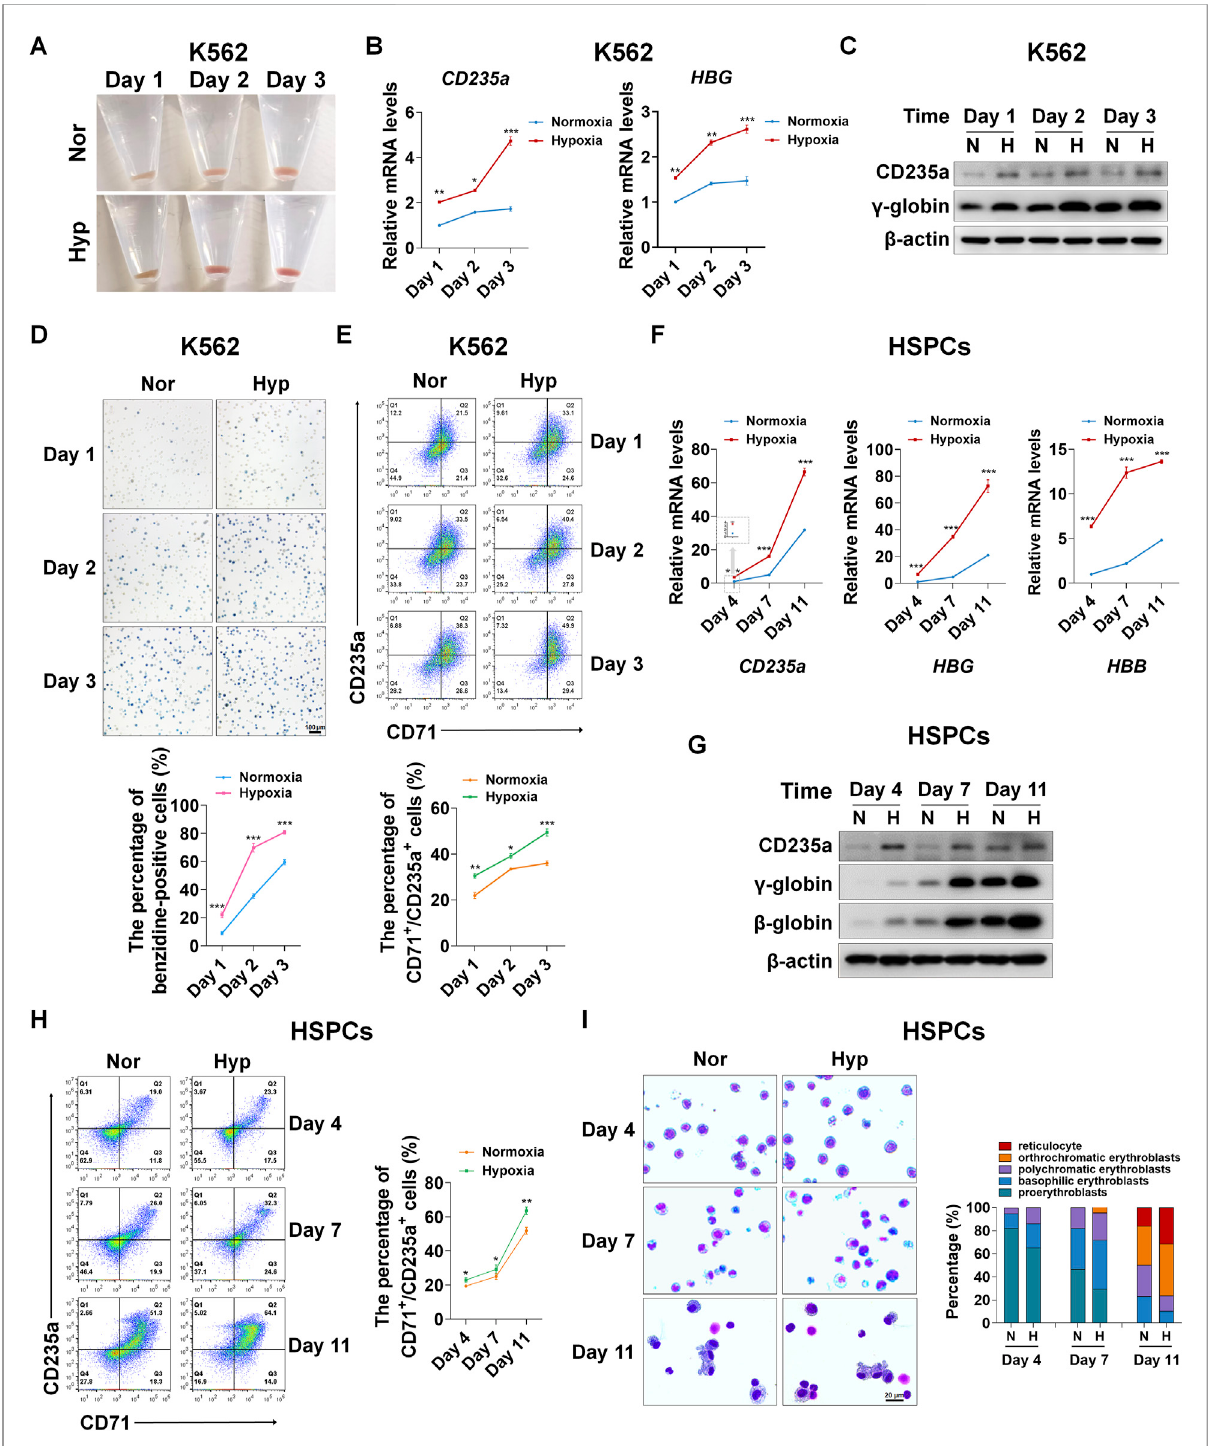
FIGURE 1 Hypoxia accelerates erythroid differentiation (A) Reddish pellets of K562 cells in the process of erythroid differentiation under normoxia and hypoxia.Redderpellets indicate moreaccumulationofhemoglobin (B) qRT-PCR analysis oftherelativemRNAlevels ofspeci fi cerythrocyte markers CD235a and HBG. qRT-PCR was performed at the indicated time points after K562 cells were exposed to normoxia or hypoxia during erythroid differentiation.* p < 0.05,** p < 0.01,*** p < 0.001,versusthecorrespondingnormoxiagroupatdifferenttimepoints (C) Westernblotanalysisof CD235aand γ -globinproteinexpressionattheindicatedtimepointsafterK562cellswereexposedtonormoxiaorhypoxia.N:normoxia; (H) hypoxia (D) Representative images of benzidine staining in K562 cells differentiated into erythrocytes. The line graph below shows the percentage